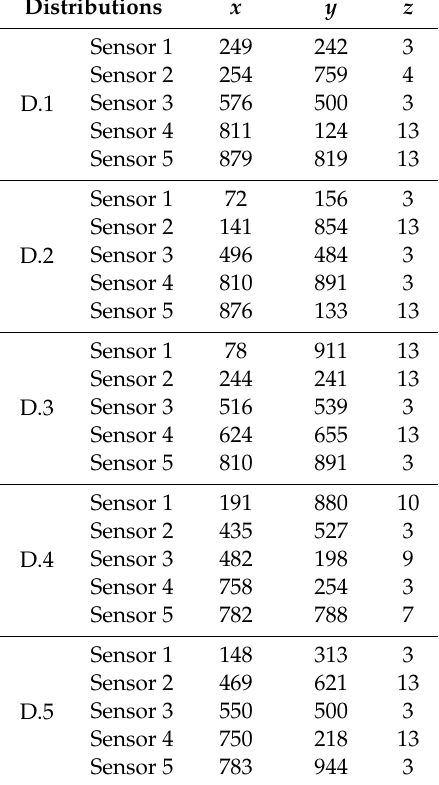
Table 2. Node distributions in meters. Five random node distributions were defined in order to analyze the accuracy level of A-TDOA and D-TDOA architectures based on their CRLB system definition. CRLB evaluation does not require a classification of WS and CS